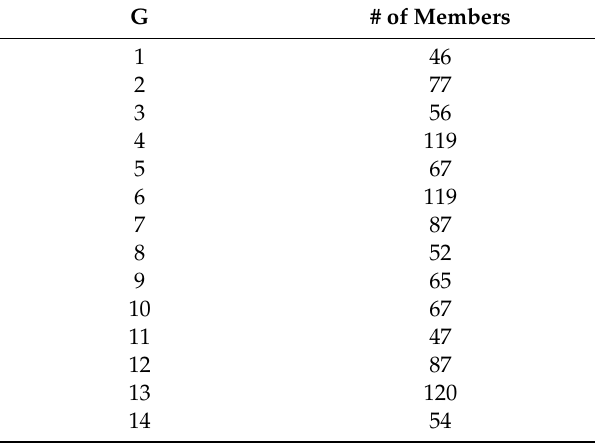
Table 1. The number of members in each cluster G = 1, ... ,14 are obtained using the functional data